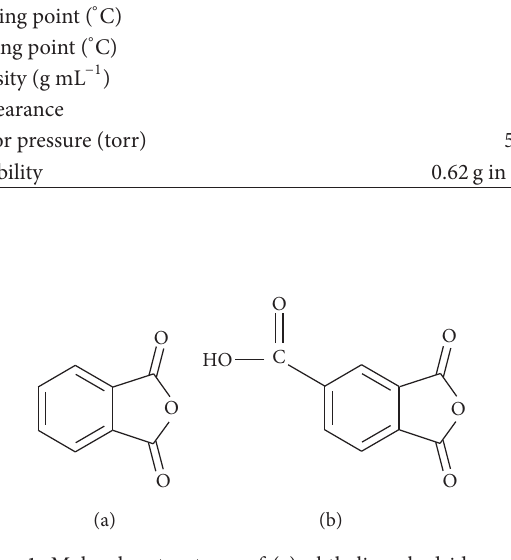
F 1: Molecular structures of (a) phthalic anhydride and (b) trimellitic anhydride.